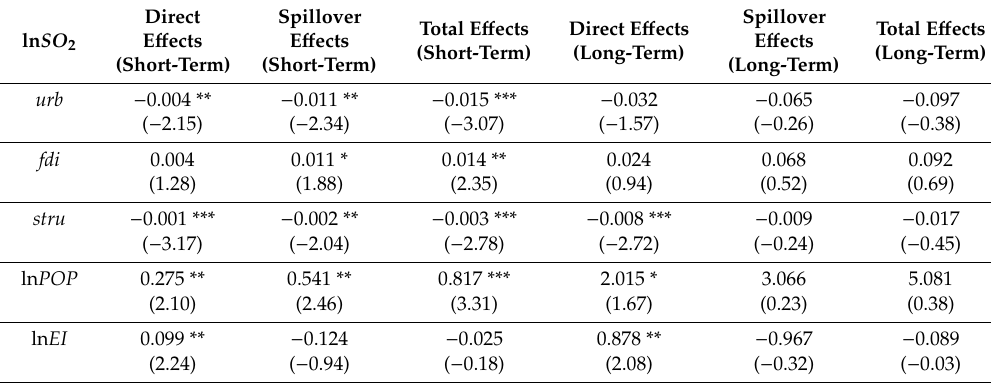
Table 5. Short- and long-term e ff ects on SO 2